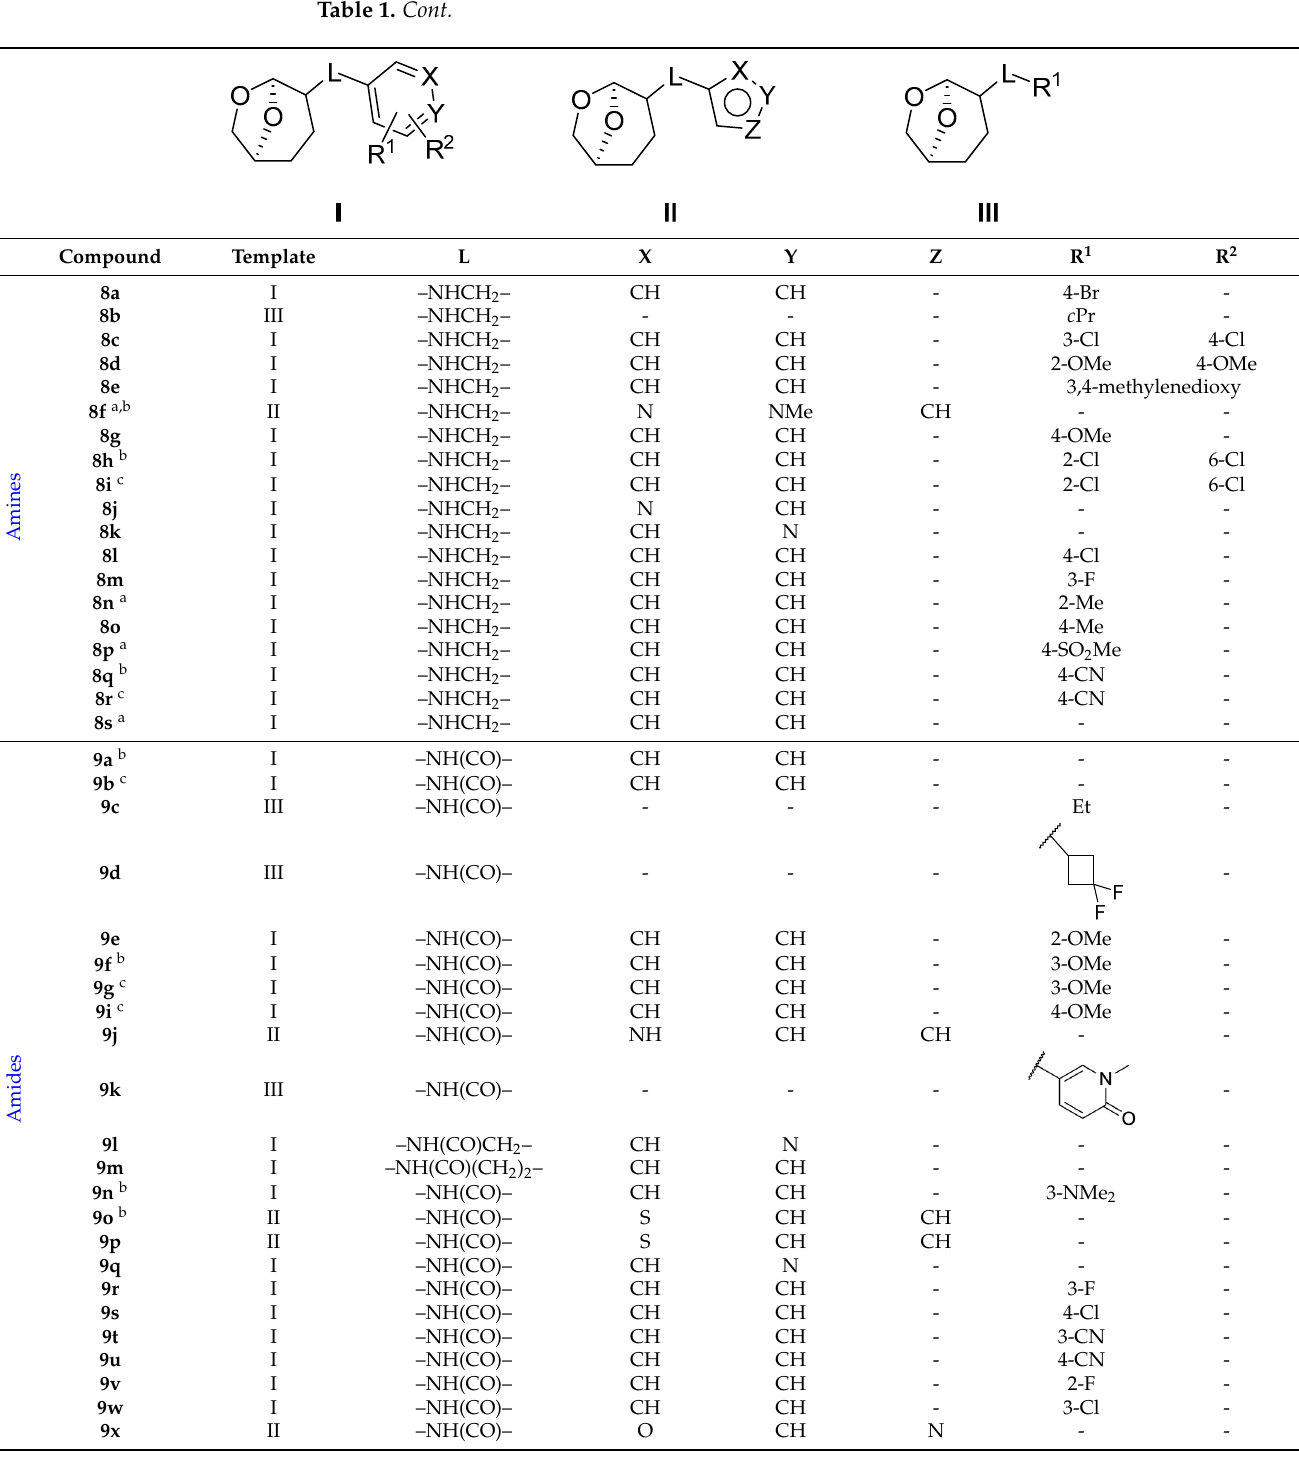
Table 1. All 100 compounds prepared in this study. Three templates (I, II, III) are used for clarity. Unless mentioned otherwise, compounds are a mixture of endo and exo diastereomers. Supplemen- tary Materials Tables S2 and S3 show all full structures, d.r. values and, where appropriate, pro- Table 1. Cont. posed relative stereochemistry of the (major)